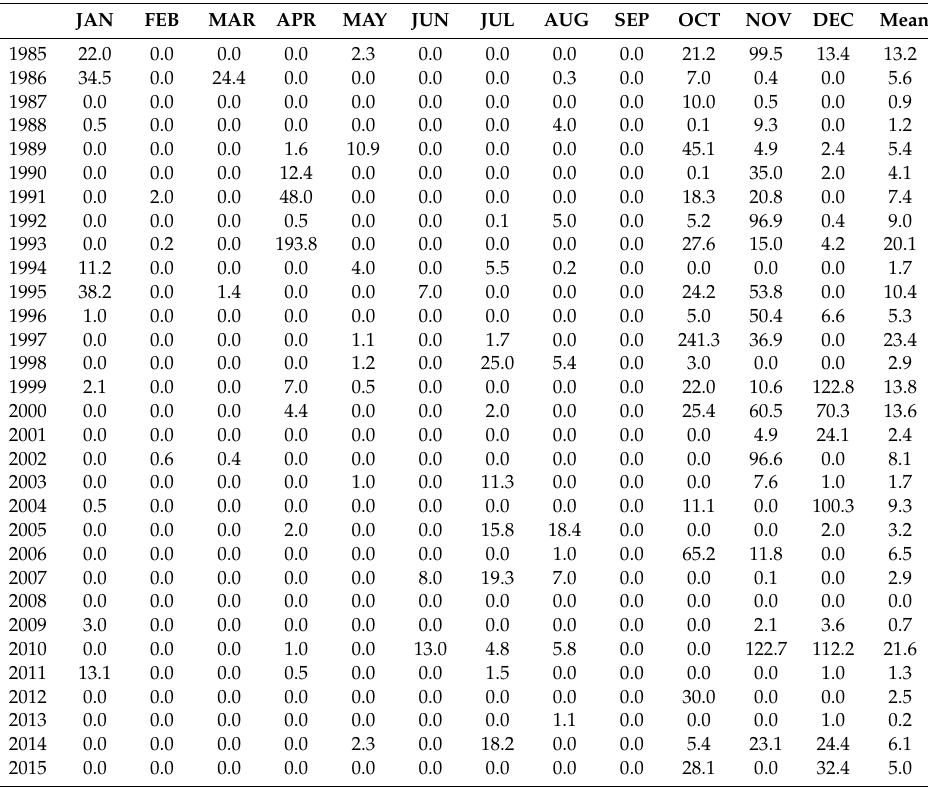
Table A3. Rainfall